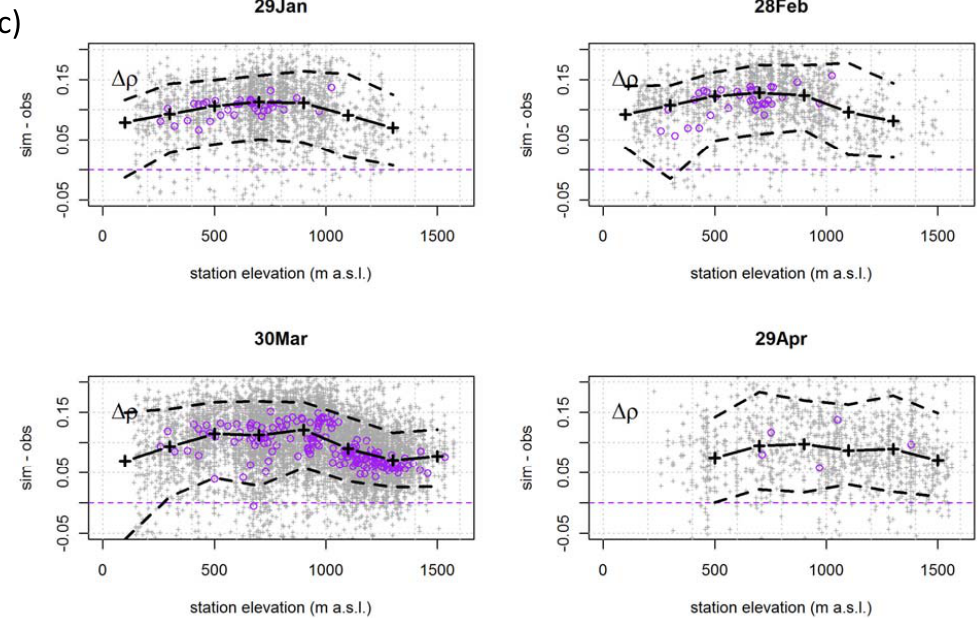
Fig. 4. Median (solid lines) and 10/90% percentiles (dashed lines) of the difference (grey dots) between the seNorge model-simulated and observed (a) snow water equivalent (SWE), (b) snow depth (SD), and (c) bulk snow density ( ρ ) at four different dates in snow seasons 1957–2011 in the HPC-data. Statistics are calculated in 200 m elevation-bins (with at least 50 observations; centers of the bins are denoted by black “+” markers). The panels (a) and (b) show the relative log-transformed difference ( Δ SD*, Δ SWE* ) and (c) the absolute difference ( Δ ρ ). The coloured circles in (a) and (b) denote the stations with “good match” (green), “overestimation” (blue) and “underestimation” (red), as explained in Fig. 3.